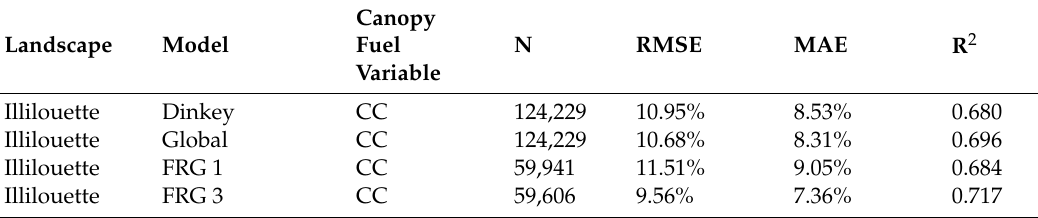
Table A2. Performance assessment of local (nearest), global, and fire regime group (FRG) models using test landscapes. All data within the landscape’s dataset used for model assessment. N refers to the number of samples used for the performance metrics, which are root mean square error (RMSE), mean absolute error (MAE), and coe ffi cient of determination (R 2